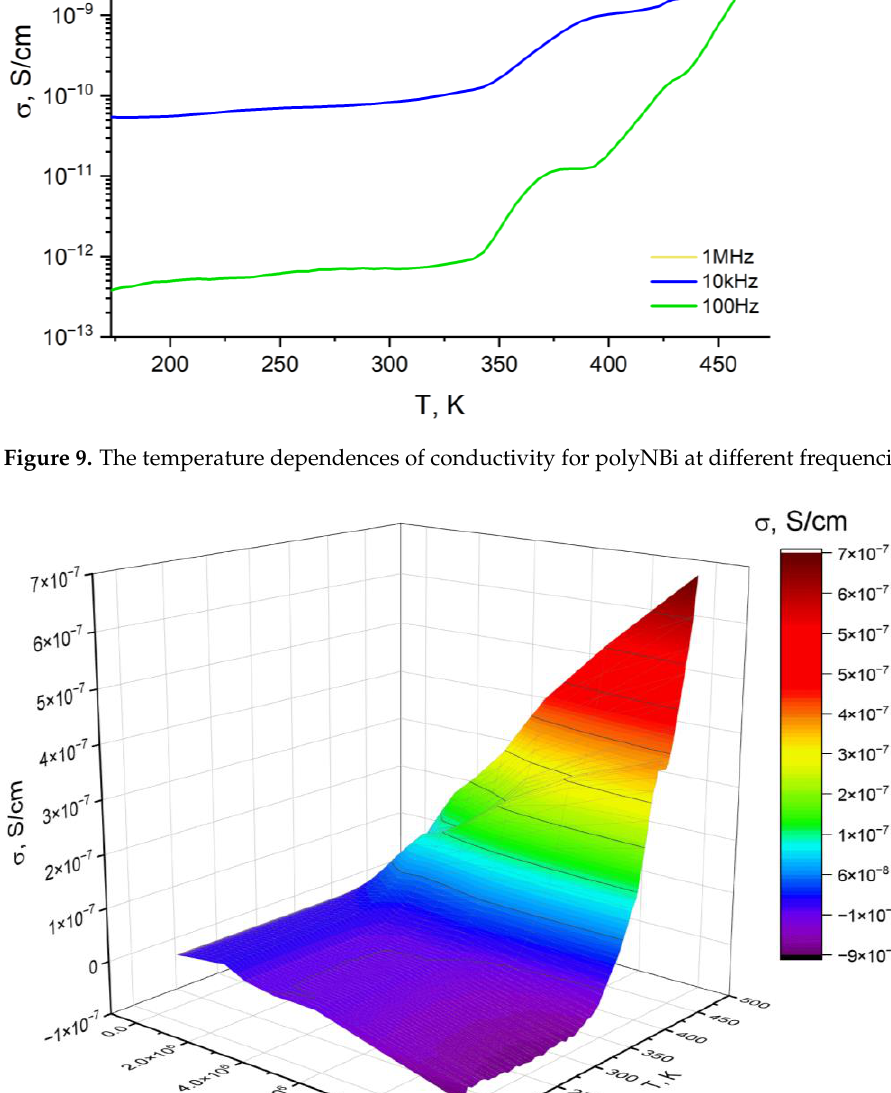
Figure 10. 3D plot of conductivity versus temperature and frequency for polyNBi.